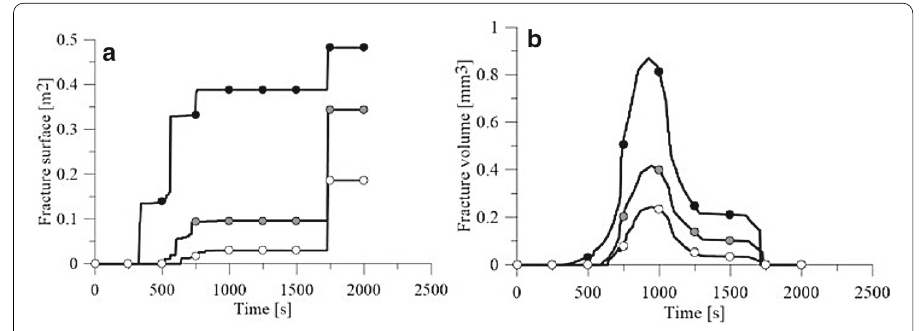
Fig. 9 Sensitivity analysis on friction angle. Black circles: 30 ◦ . Gray circles: 38 ◦ . White circles: 45 ◦ . a Fracture surface versus time. b Fracture volume versus time